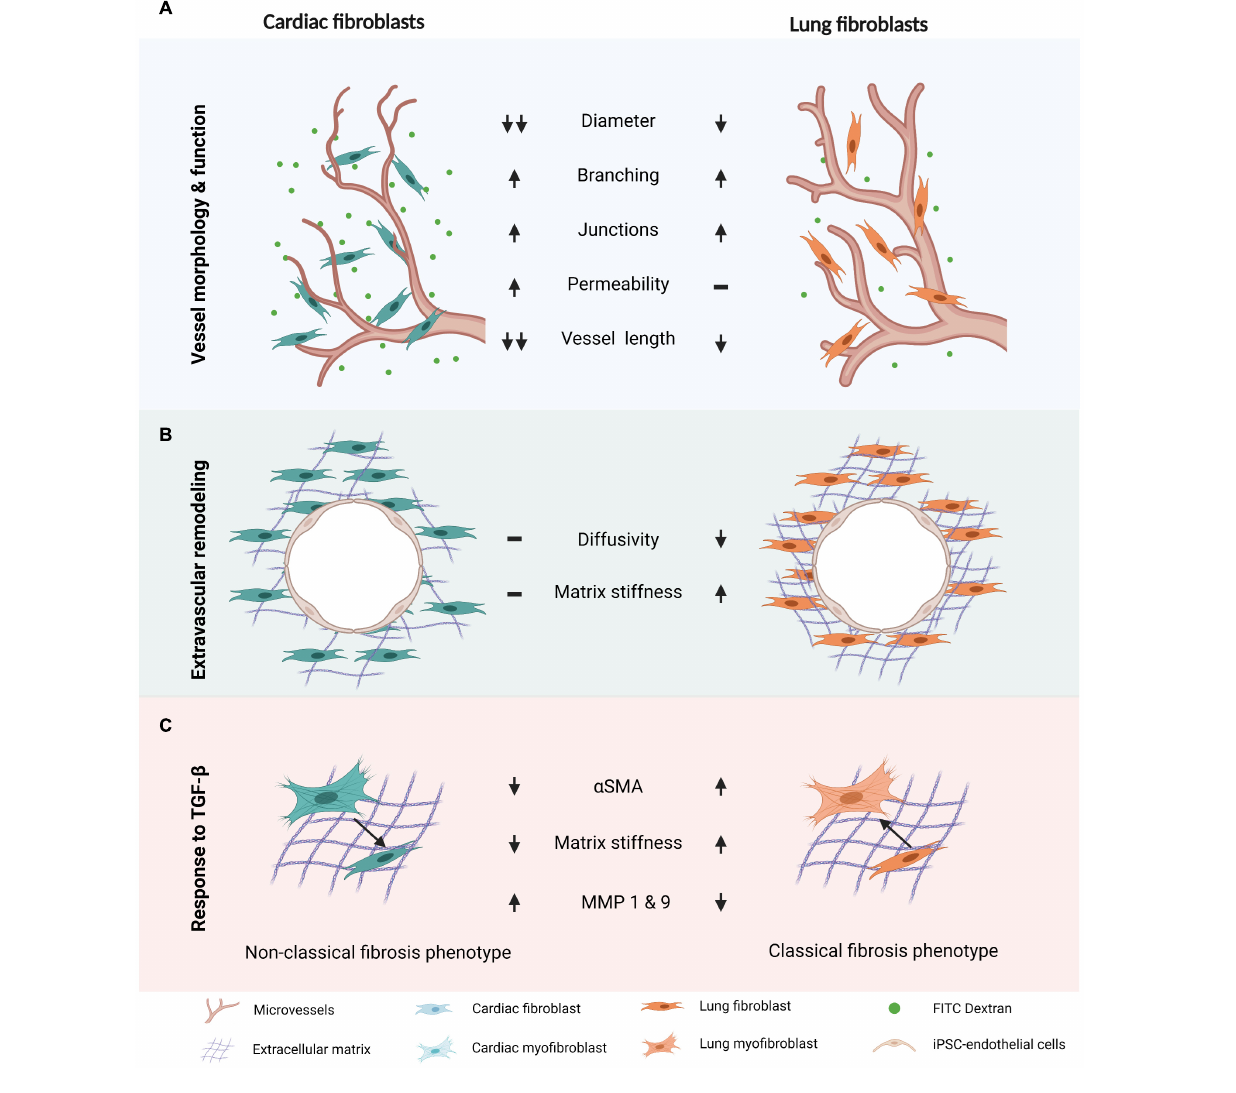
FIGURE 5 | Differential response of cardiac and pulmonary-like microvascular tissues in induced fibrosis. (A) Vessel morphology and endothelial barrier function are impacted by stromal cell type. (B) Extravascular matrix is differentially remodeled in cardiac and lung microvascular tissues. (C) There is a differential response to TGF- β stimulation in the cardiac and lung microvascular tissues. In (A,B) , trends are in comparison to the monoculture microvascular tissue